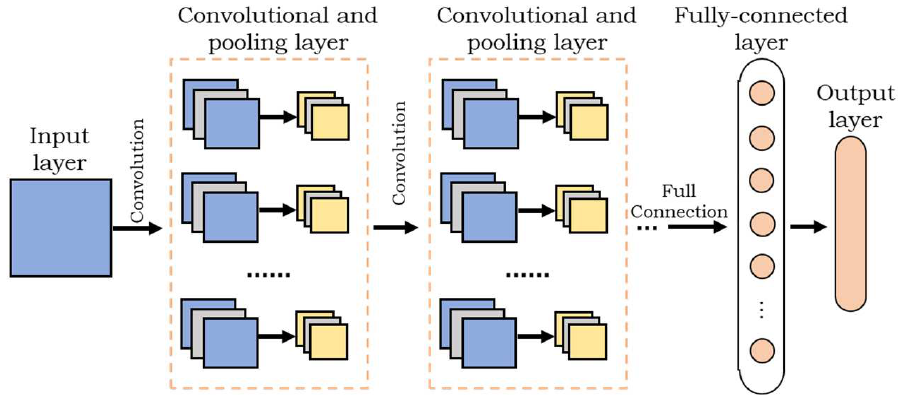
Figure 2. Classical structure of CNN.